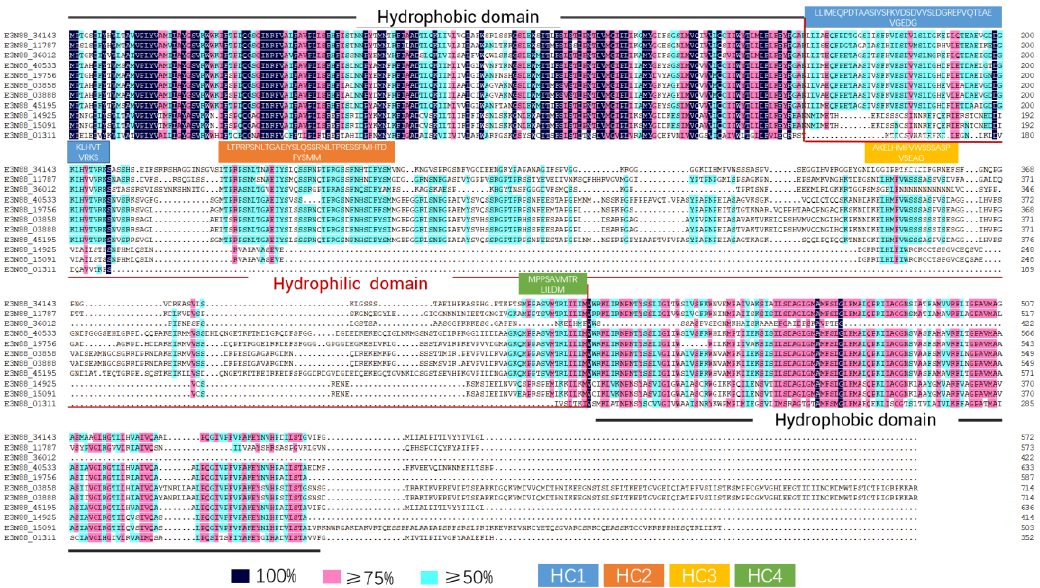
Figure 6. Multiple sequence alignment of PIN proteins in M. micrantha . Identical (100%), conservative ( ≥ 75%) and block ( ≥ 50%) of similar amino acid residues are shaded in deep blue, pink and light green, respectively. The black line indicates hydrophobic domain, the red line indicates hydrophilic domain. The motifs that constitute the highly conserved canonical regions HC1-HC4 within the common central hydrophilic region are shown as blue, orange, yellow and green rectangles,